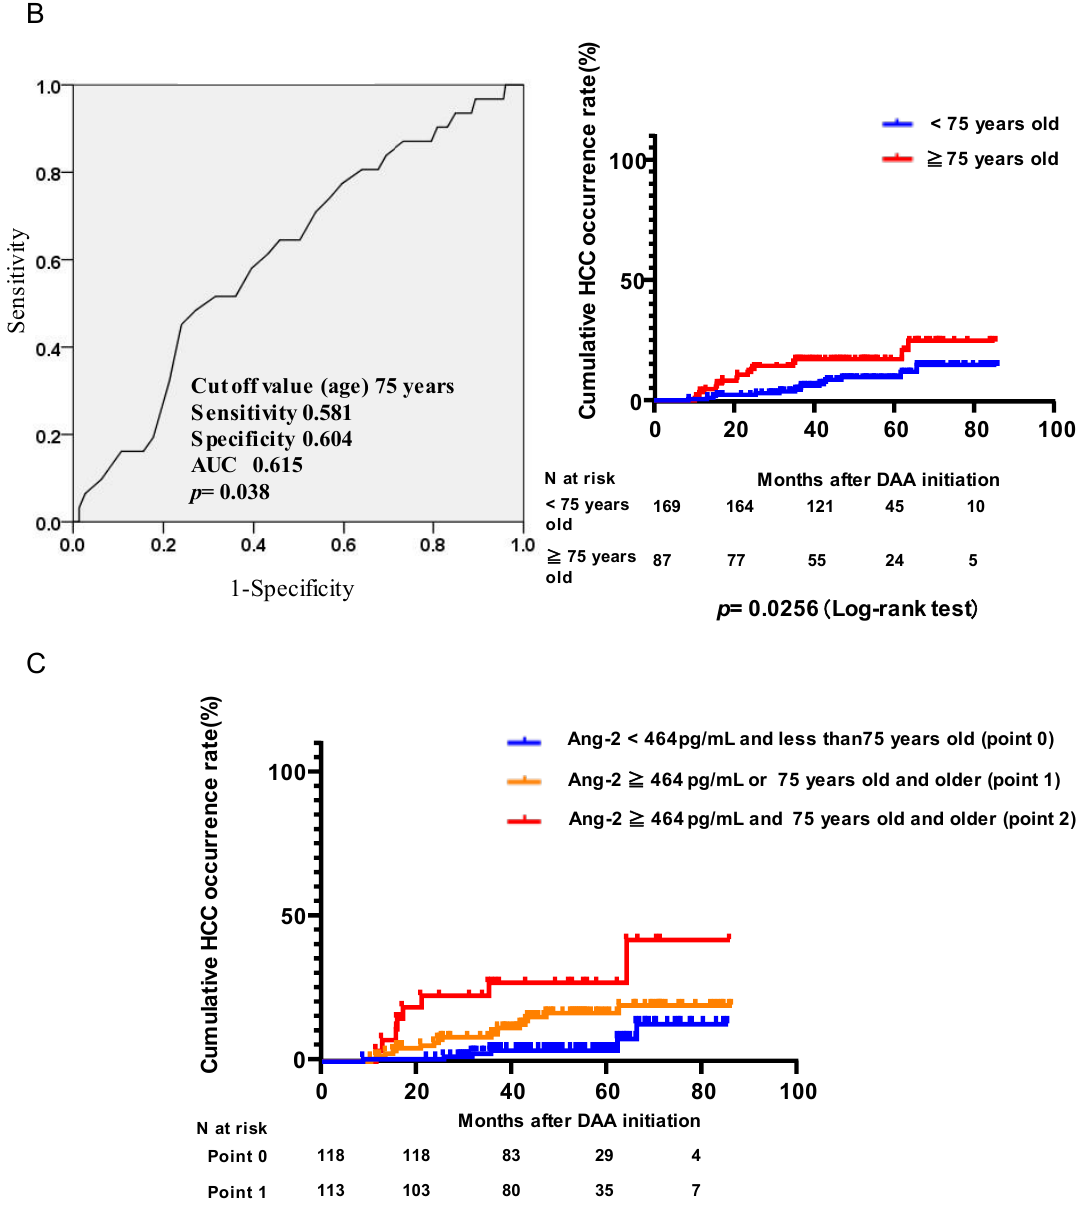
Figure 2. ROC curve analysis to determine the optimal cut-off values for predicting HCC occurrence and cumulative HCC occurrence according to ( A ) the serum Ang2 value and ( B ) age. ( A ) The optimal cut-off value for baseline Ang2 was set at 464 pg/mL (sensitivity, 0.59; specificity, 0.729; AUC, 0.683; p = 0.001). Comparison of the cumulative HCC occurrence rate (%) between patients with baseline serum Ang2 levels ≥ 464 pg/mL and <464 pg/mL. ( B ) The optimal cut-off value for baseline age was set at 75 years (sensitivity, 0.581; specificity, 0.604; AUC, 0.615; p = 0.038). Comparison of the cumulative HCC occurrence rate (%) between patients with baseline age ≥ 75 years and <75 years. ( C ) One point was assigned for baseline age ≥ 75 years or Ang2 level ≥ 464 pg/mL. Individuals were classified into three groups according to the total points (0, 1, and 2) to analyze the risk of HCC after successful HCV eradication. The cumulative HCC occurrence rate (%) after DAA treatment was analyzed. ROC, receiver operating characteristic; HCC, hepatocellular carcinoma; SVR, sustained virological response; DAAs, direct-acting antivirals.